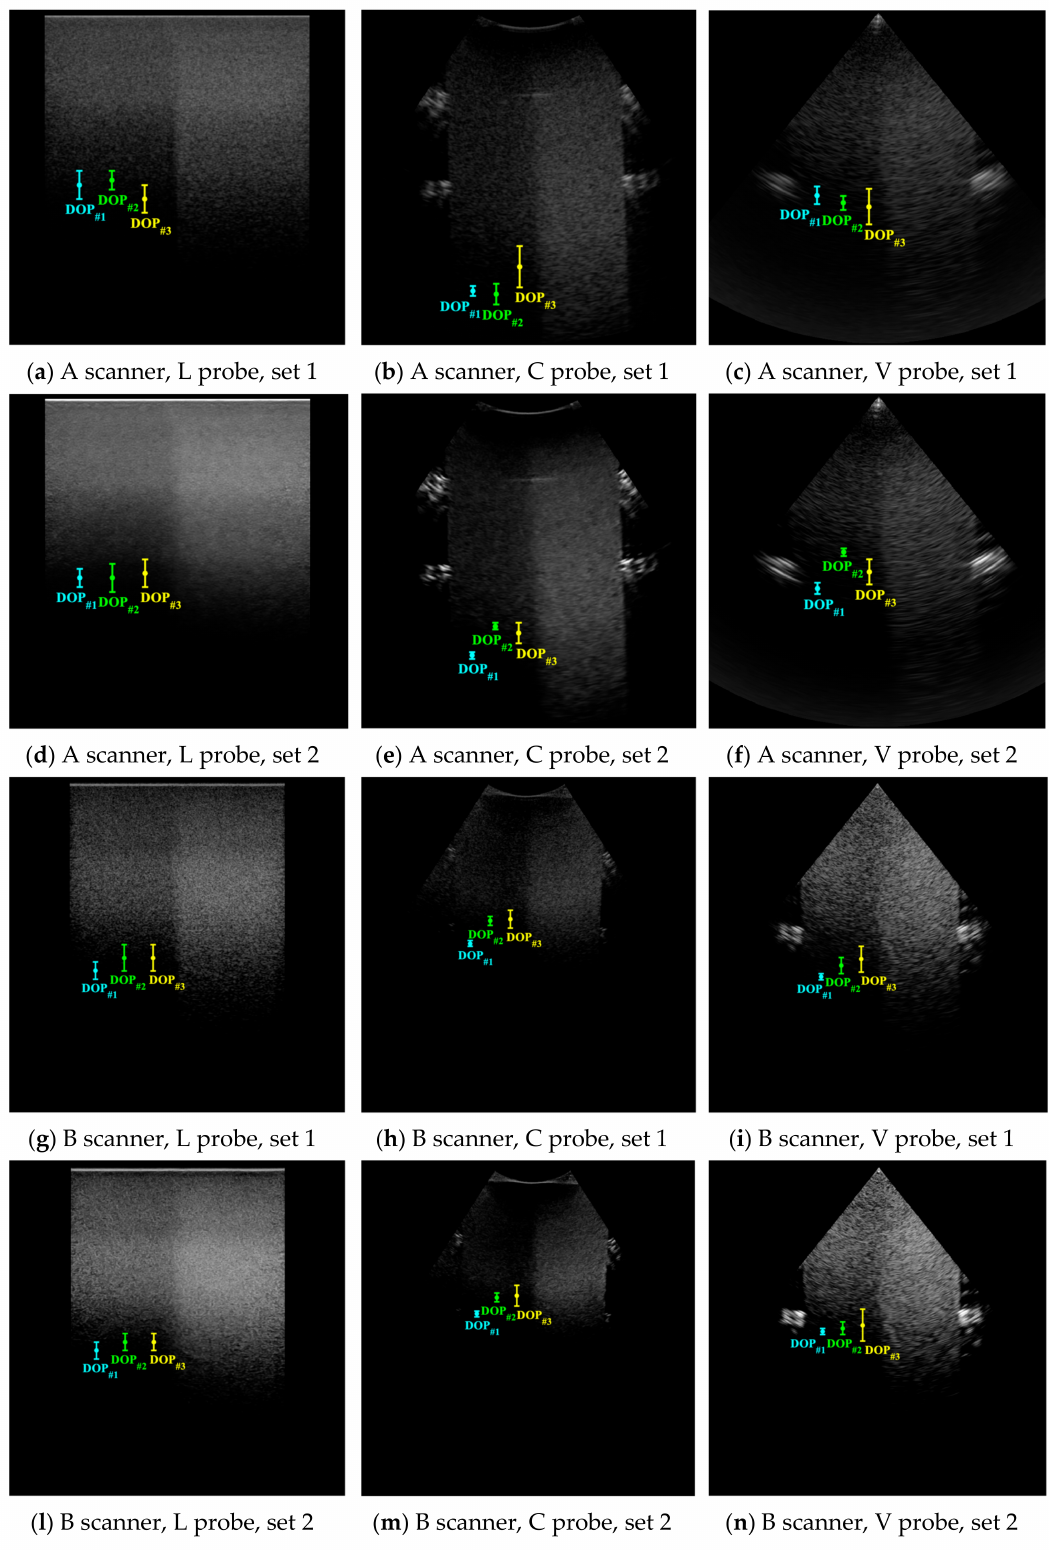
Figure 1. Depth of penetration for A and B diagnostic systems equipped with linear L, convex C, vector V probes tested in sets 1 and 2. DOP #1 and DOP #2 were evaluated through the AdSTM and the TTM [18], respectively, while DOP #3 was assessed by naked eye. DOP values are represented with related error bars due to the total uncertainties reported in Table